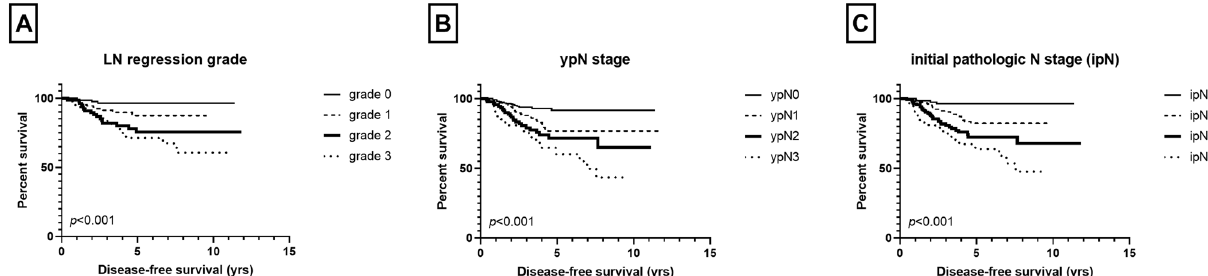
Figure 2. Disease-free survival based on lymph node (LN) status after neoadjuvant chemotherapy. There is a stepwise decline in survival with each increase in LN regression grade (A) , ypN stage (B) , and presumed initial pathologic N stage (C) in the whole group.